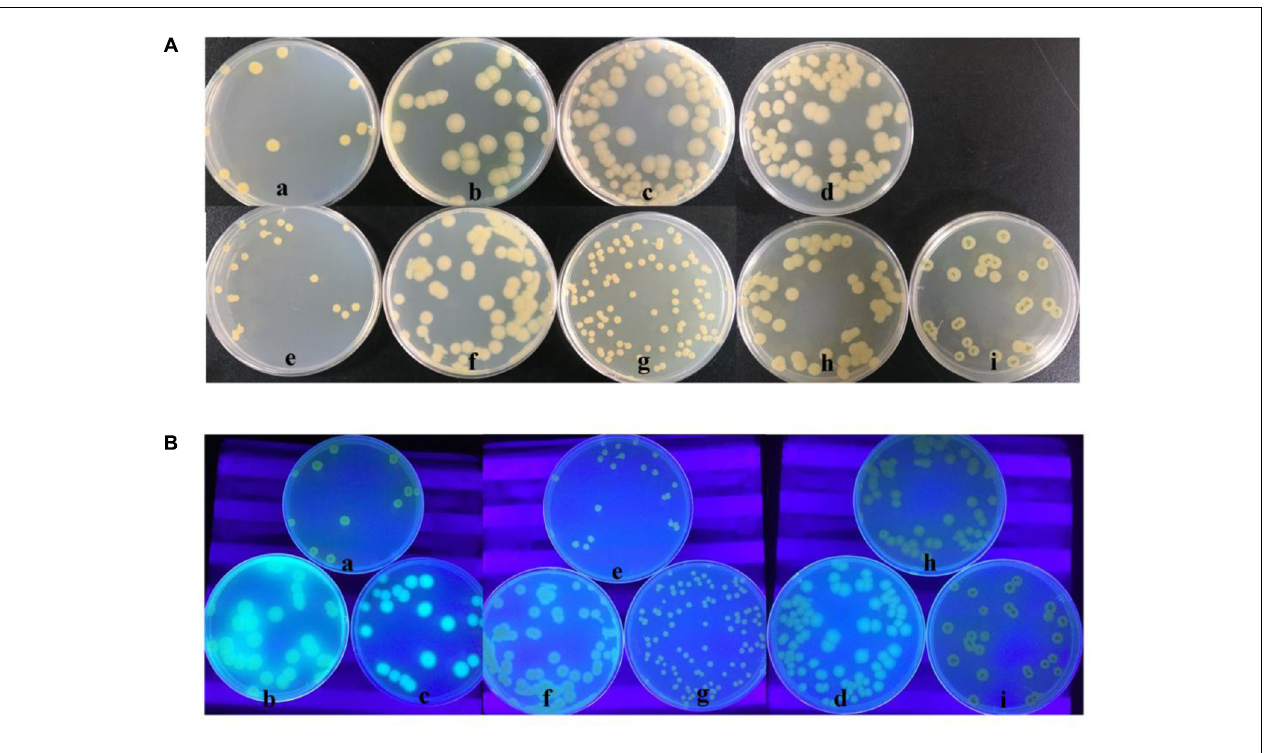
FIGURE 7 | The Comparison of morphology (A) and the fluorescence phenomenon under UV light (B) among HT66 (a), HT66-FLUO (b), HT66 (cid:49) gacA (c), HT66 (cid:49) gacS (d), HT66-pBBR1MCS2 (e), the overexpressing gacA strain, HT66-FLUO-pBBR- gacA (f), the complemented gacA mutant strain, HT66 (cid:49) gacA -pBBR- gacA (g), the complemented gacS mutant strain, HT66 (cid:49) gacS -pBBR- gacS (h), the overexpressing gacS strain, HT66-FLUO-pBBR- gacS